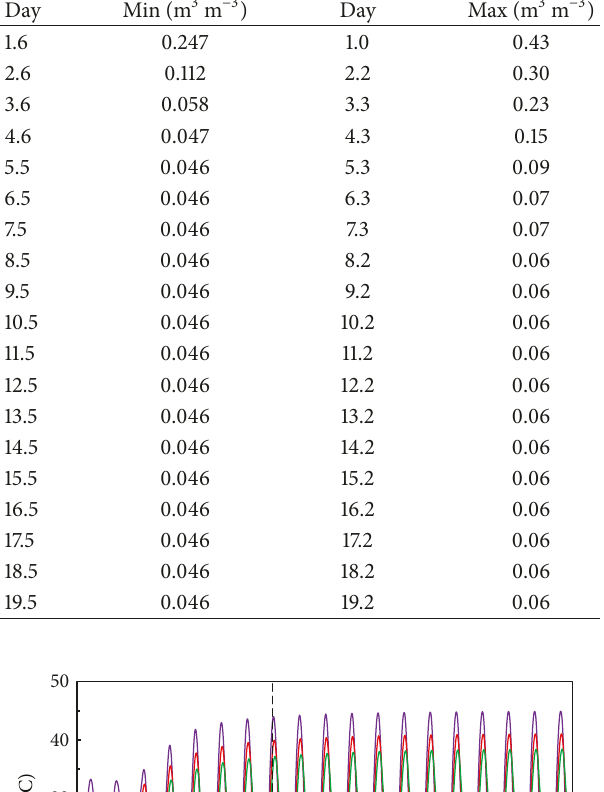
Table 3: Maximum and minimum values of soil water content and the corresponding time points.